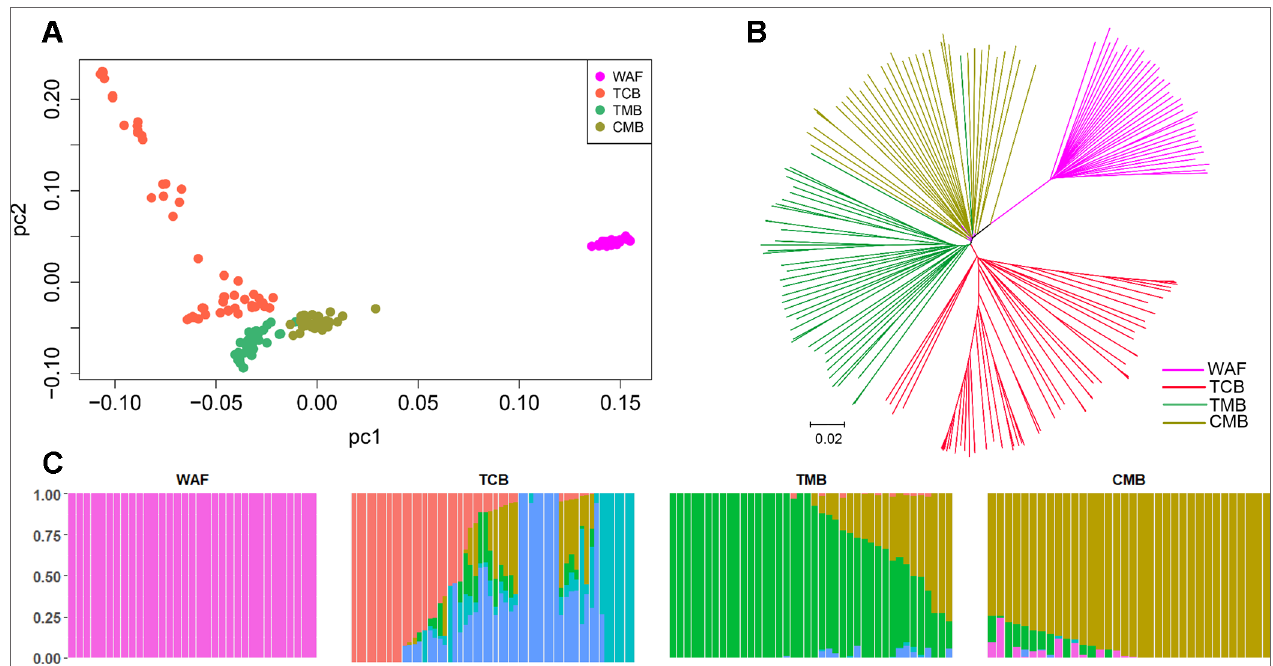
FIGURe 3 | Population structure in the sample set analyzed. (A – C) Principal component analysis (A) , a neighbor-joining tree (B) and an admixture analysis (C) . Principal component analysis identified the four groups clearly. The neighbor-joining tree has four distinct branches separating four major components of population structure that correspond to the four geographical groups of sample; samples from WAF are separated from TCB, TMB, and CMB by long branches. Admixture analysis distinguished these four major components according to an optimized cluster value of K = 6, and multiple parasite subpopulations were found in TCB. WAF, West Africa; TCB, Thai–Cambodia border; TMB, Thai–Myanmar border; CMB, China–Myanmar border.